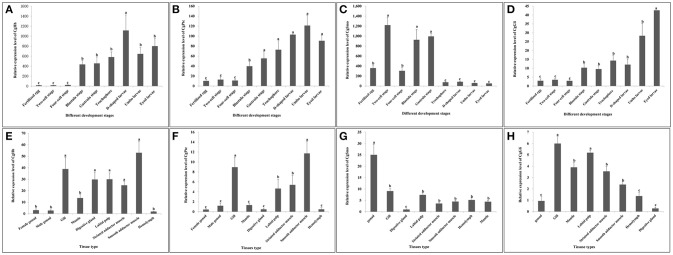
(A–D) Expression profiles of key genes during embryo-larval developmental stages. (E–H) Expression profiles of key genes in adult different tissues. Different letters indicated significantly different (P < 0.05). The letters “a,” “b,” and “c” indicate the significance of the differences between two groups. Firstly, the whole mean of gene expression is ranked from large to small. The maximum average is marked the letter “a” and this average is compared with the following averages. Where the difference is not significant, the letter “a” is marked; otherwise, the letter “b” is marked. Secondly, the maximum average marked “b” is used as the standard deduction and compared with the following unmarked averages. Where the difference is not significant, the letter “b” is marked; otherwise, the letter “c” is marked.